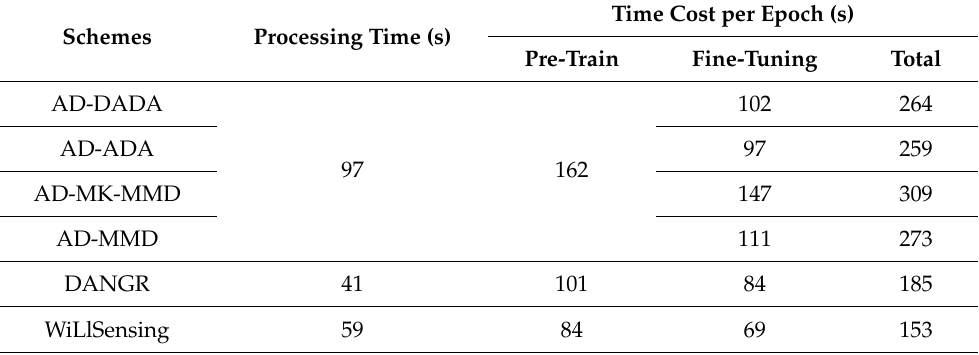
Table 7. Time cost of all